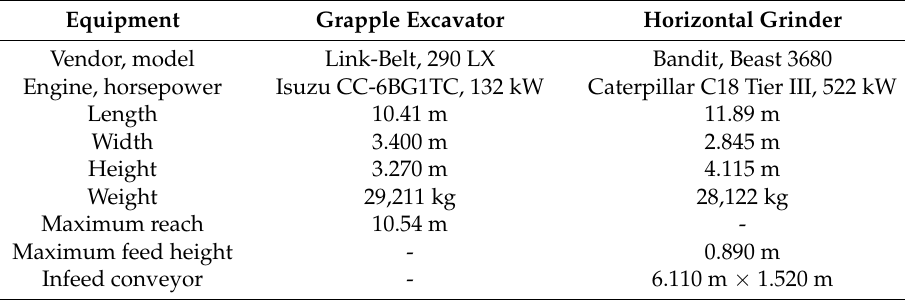
Table 1. Equipment and engines for biomass processing.